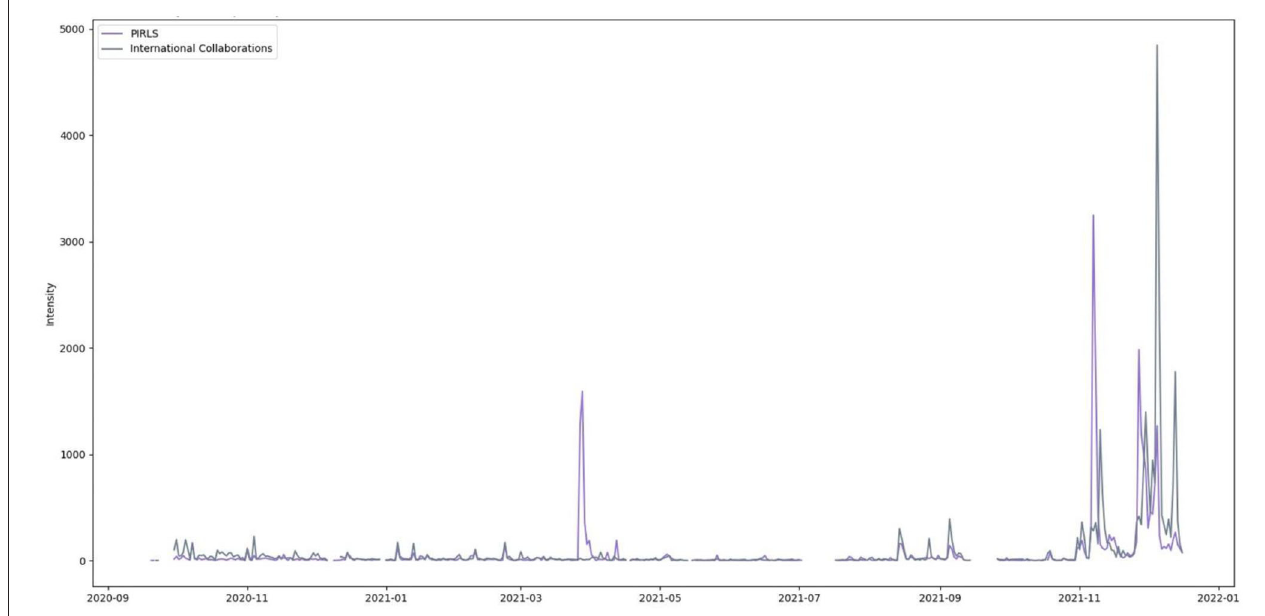
FIGURE 10 | Temporal progression of parameters (accountability &